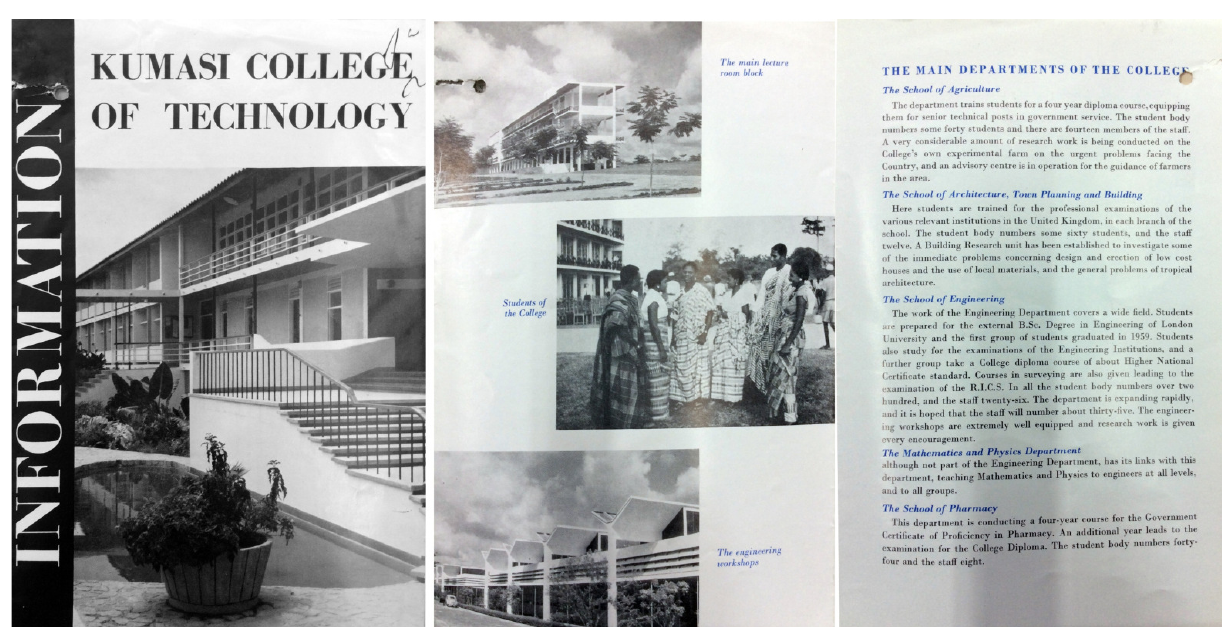
Figure 2. Kumasi College of Technology leaflet. Source: “Information: Kumasi College of Technology” [ca. 1959].